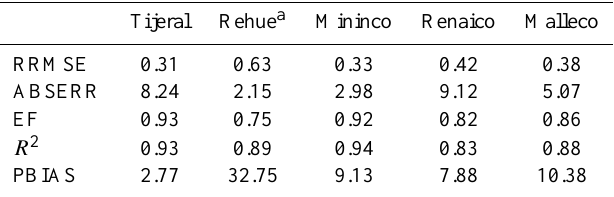
Table 10. RMS error, absolute error, efficiency and determination coefficient calculated for the period 1977–1982.